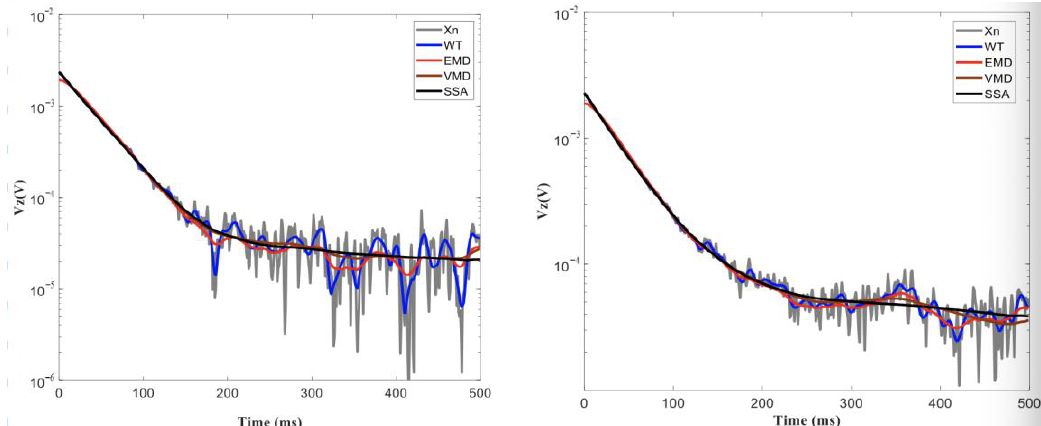
Figure 12. Comparison of two measured attenuation curves after de-nosing.